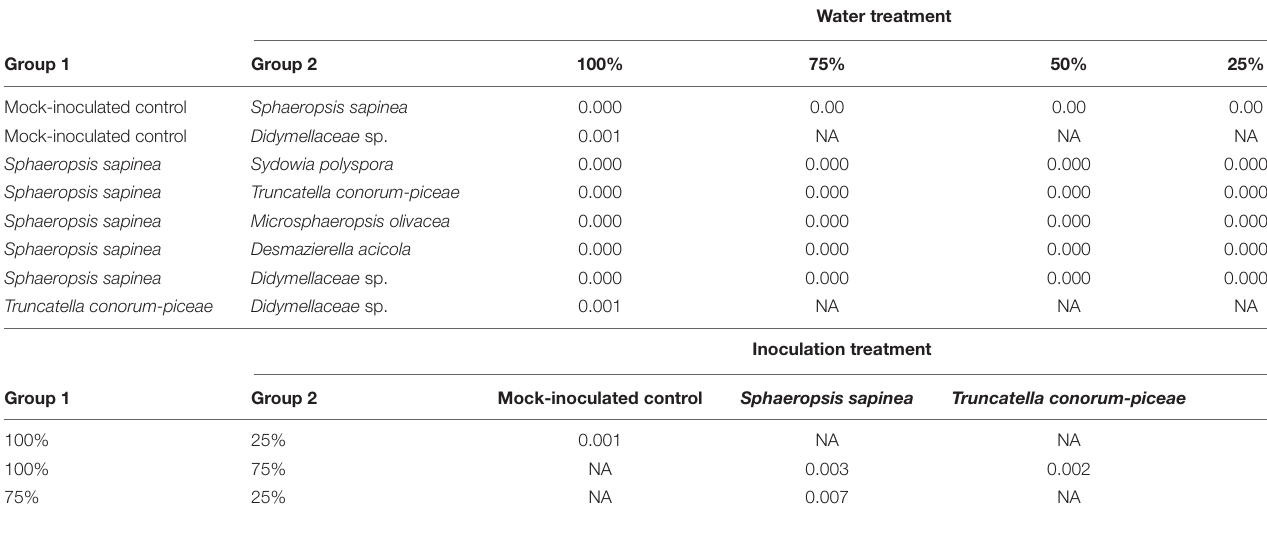
TABLE 6 | Statistical differences of necrosis length between different groups ( p <